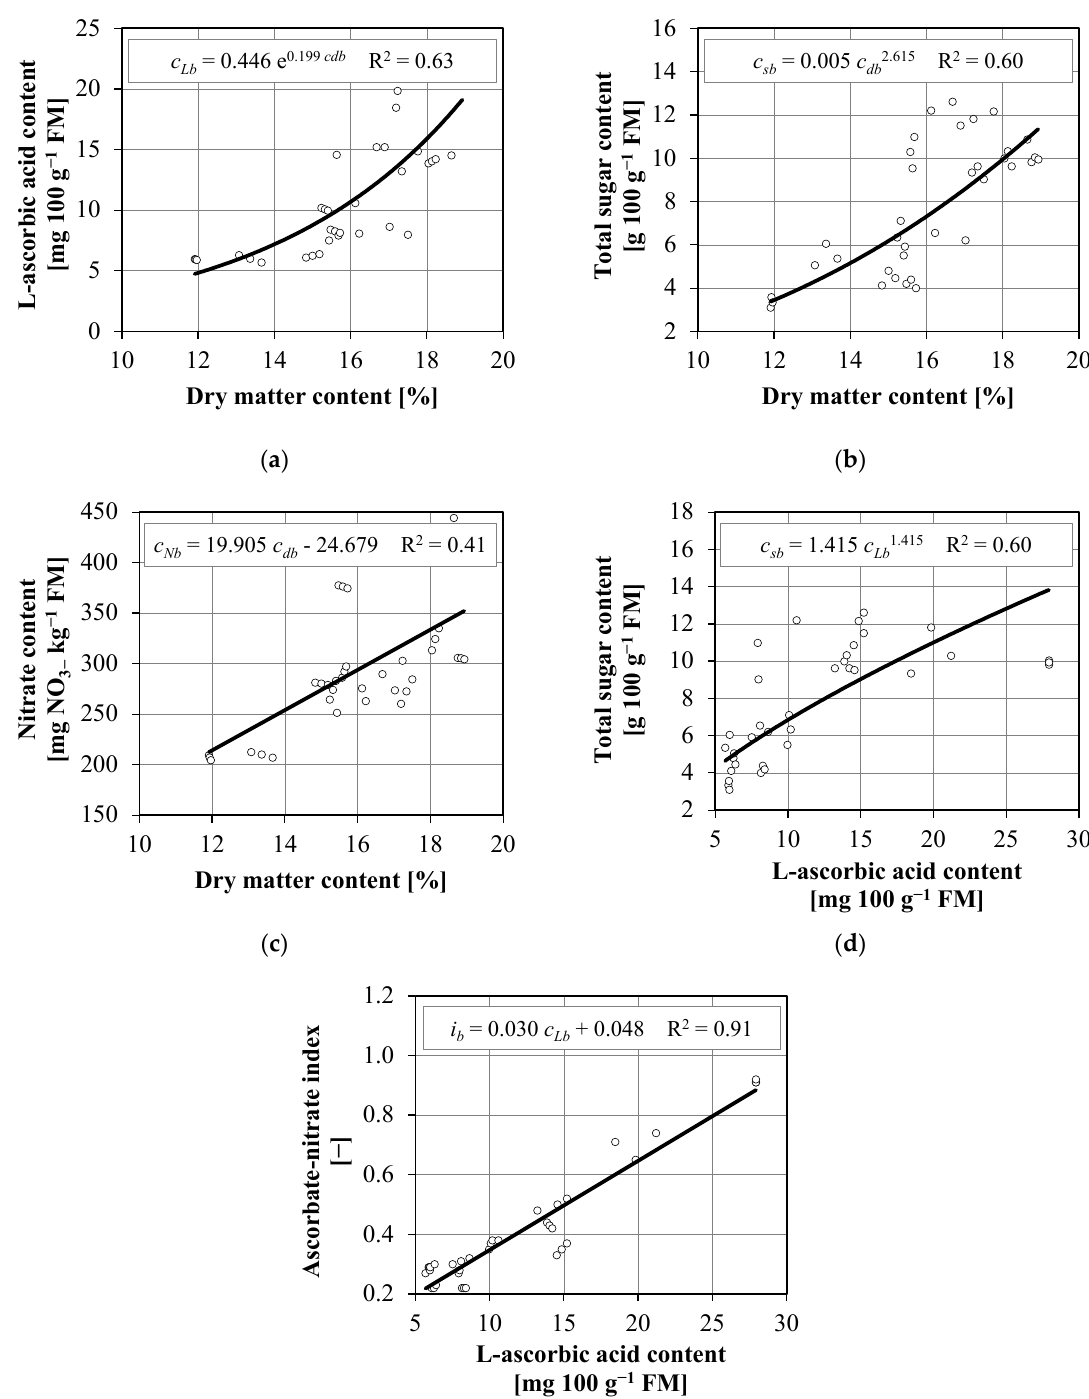
Figure 6. Correlations between the chemical composition parameters of shallot bulbs: ( a ) dry matter content and L-ascorbic acid content, ( b ) dry matter content and total sugar content, ( c ) dry matter content and nitrate content, ( d ) L-ascorbic acid content and total sugar content, ( e ) L-ascorbic acid content and ascorbate-nitrate index.